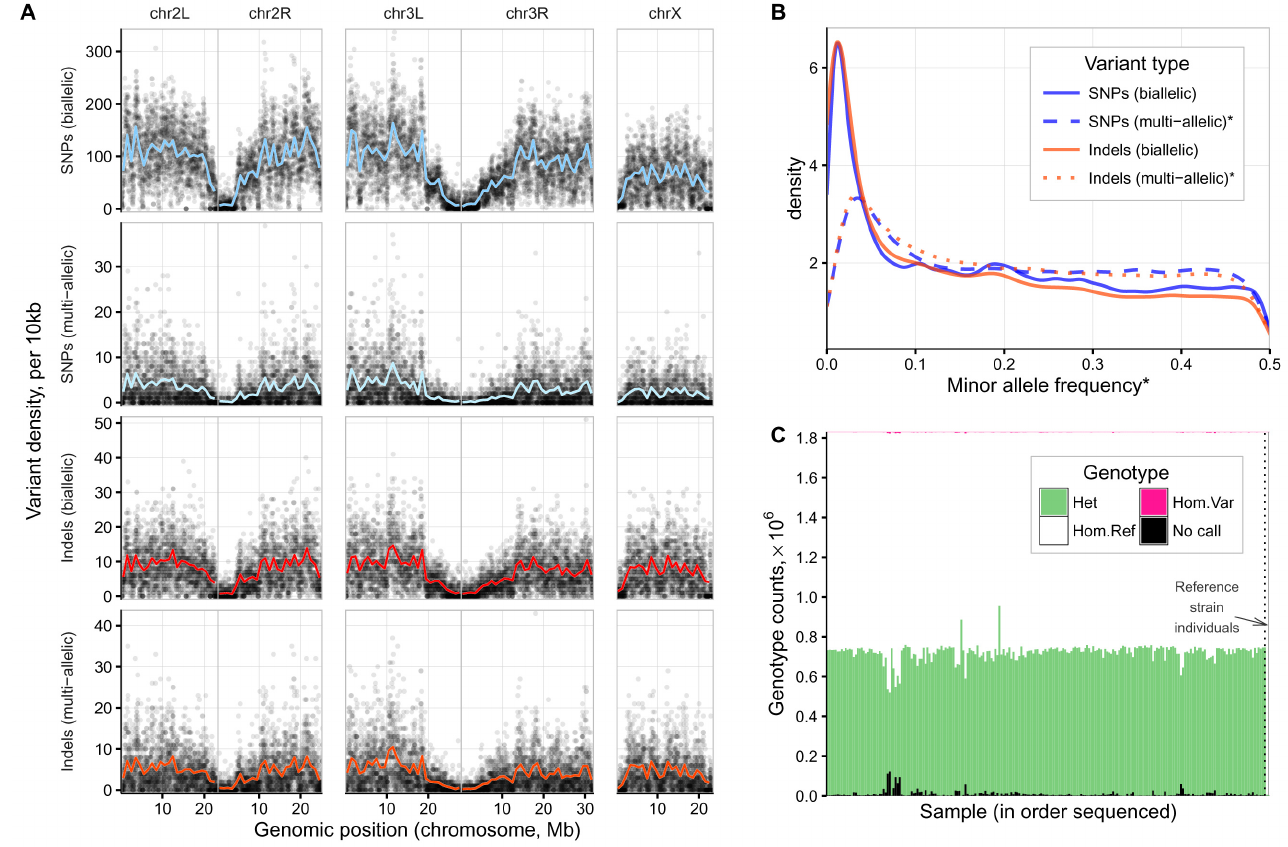
Figure 4. Haplotype Caller small variant results. A : Density of common variants across the genome (MAF>0.05 (Variants from the in-house reference line are included but account for less than 3,686 of the 1,825,917 common variants plotted (<0.2%). B : Allele frequency distribution by variant type. *MAF values were calculated from the count of heterozygous calls, and so for multi-allelic variants, the MAF is derived from the combined count of both alternate alleles. C : Genotype counts per individual genotyped. Data generated using GATK/3.4 VariantEvaluation function. Data and R code for this figure are located at https://doi.org/10.5281/zenodo.159282.